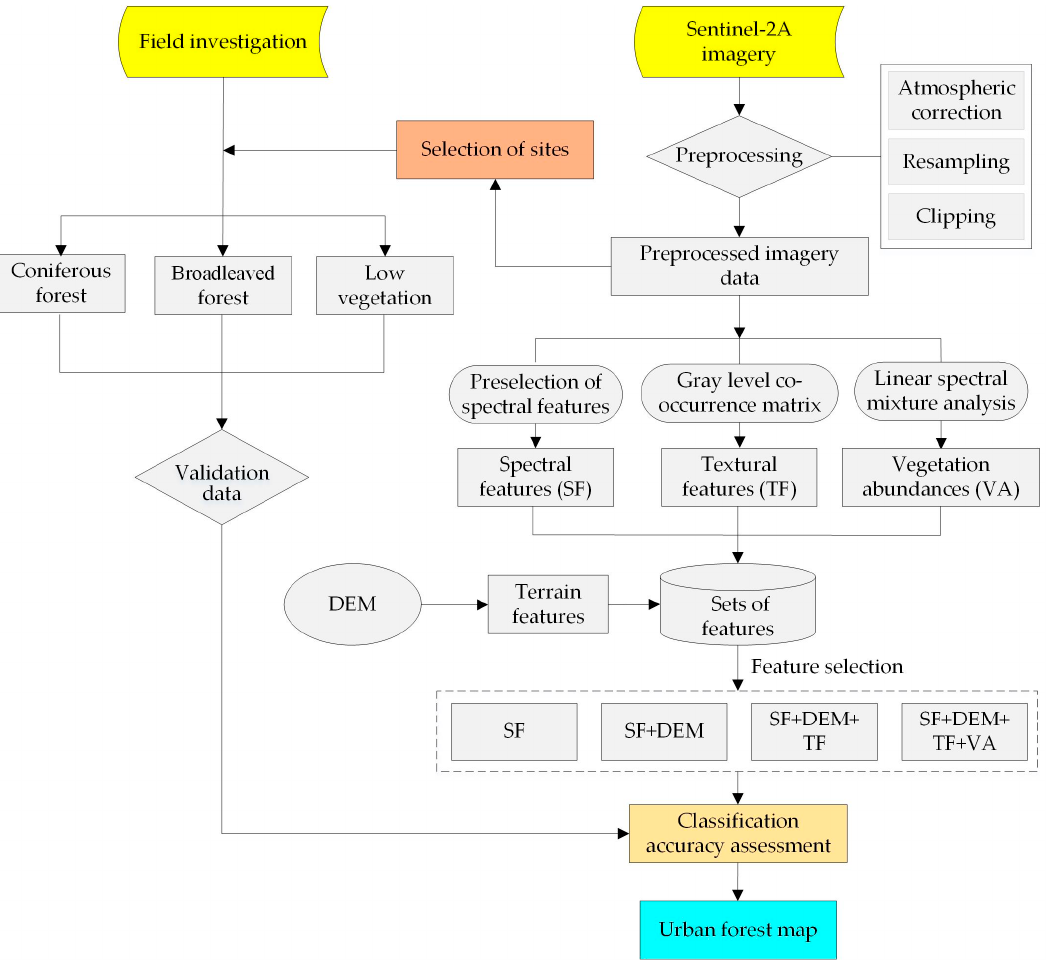
Figure 2. Technical flowchart of discriminating urban forest types in our study. The step in the dashed-line rectangle represents the four support vector machine (SVM) classification models constructed with four different sets of features. SF refers to the spectral features; DEM refers to the digital elevation model, selected from terrain features; TF refers to the textural features; and VA refers to the vegetation abundances.